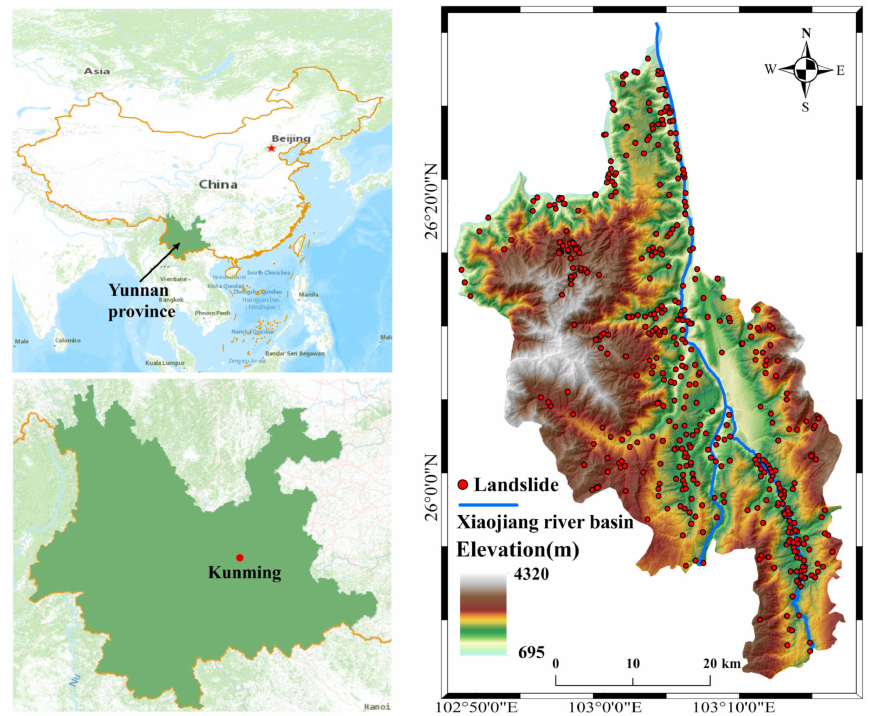
Figure 1. Geographical location and landslide distribution in the study